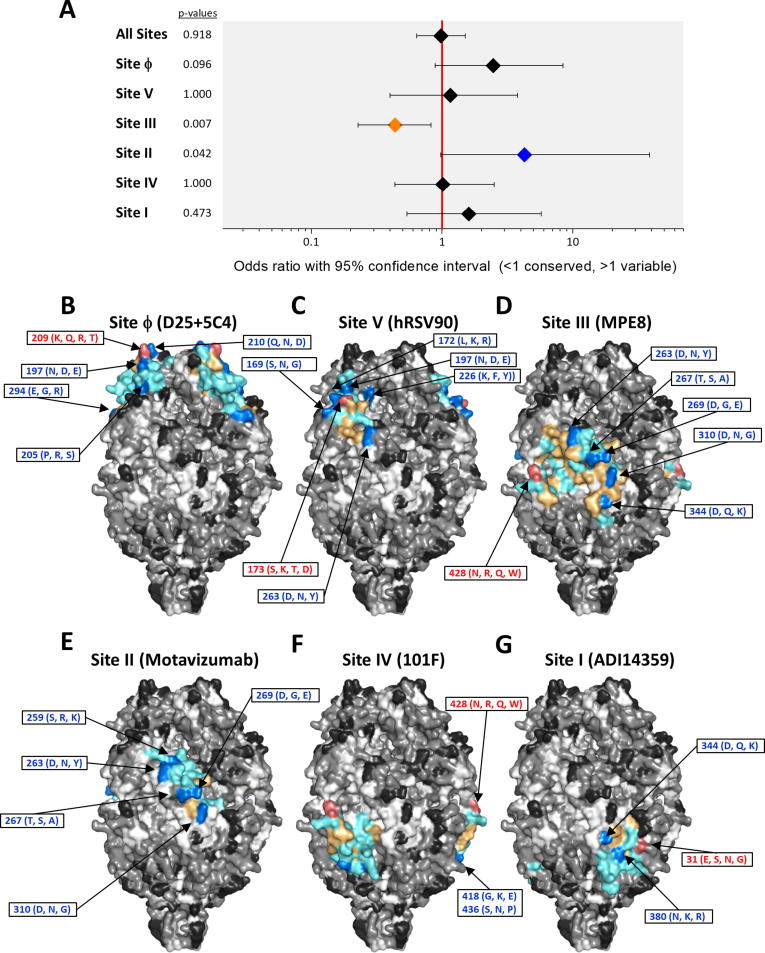
Location of amino acid differences between A2 and hMPV strains on the structure of prefusion hRSV F. Structures and changes are shown as in Fig. 3. The changes are listed in Supplementary Table S4.